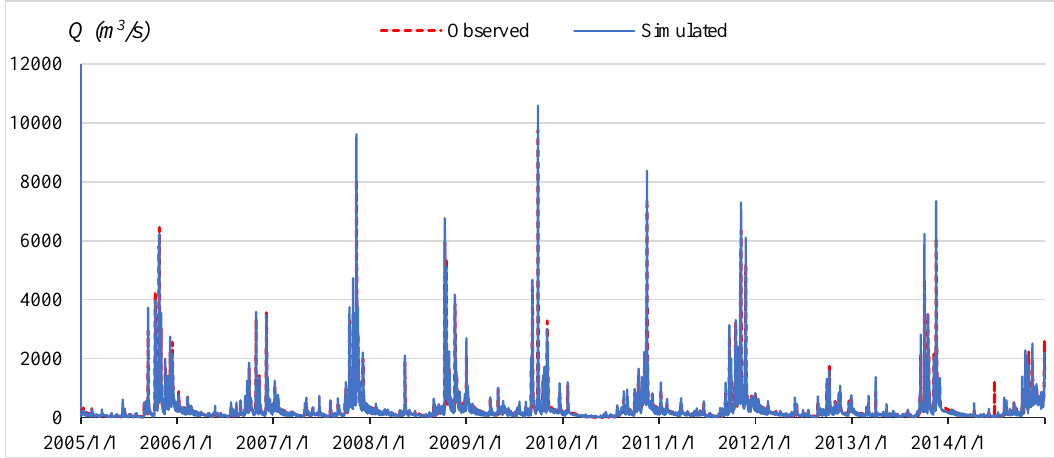
Sensors 2020 , 20 , x FOR PEER REVIEW Figure 10. The validation water discharge at the Nong Son hydrological station during 2005–2014. Figure 10. The validation water discharge at the Nong Son hydrological station during 2005–2014. Figure 10. The validation water discharge at the Nong Son hydrological station during 2005–2014.